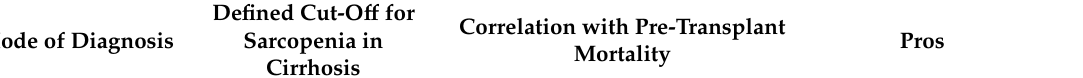
Table 1. Summary of existing diagnostic techniques for sarcopenia in